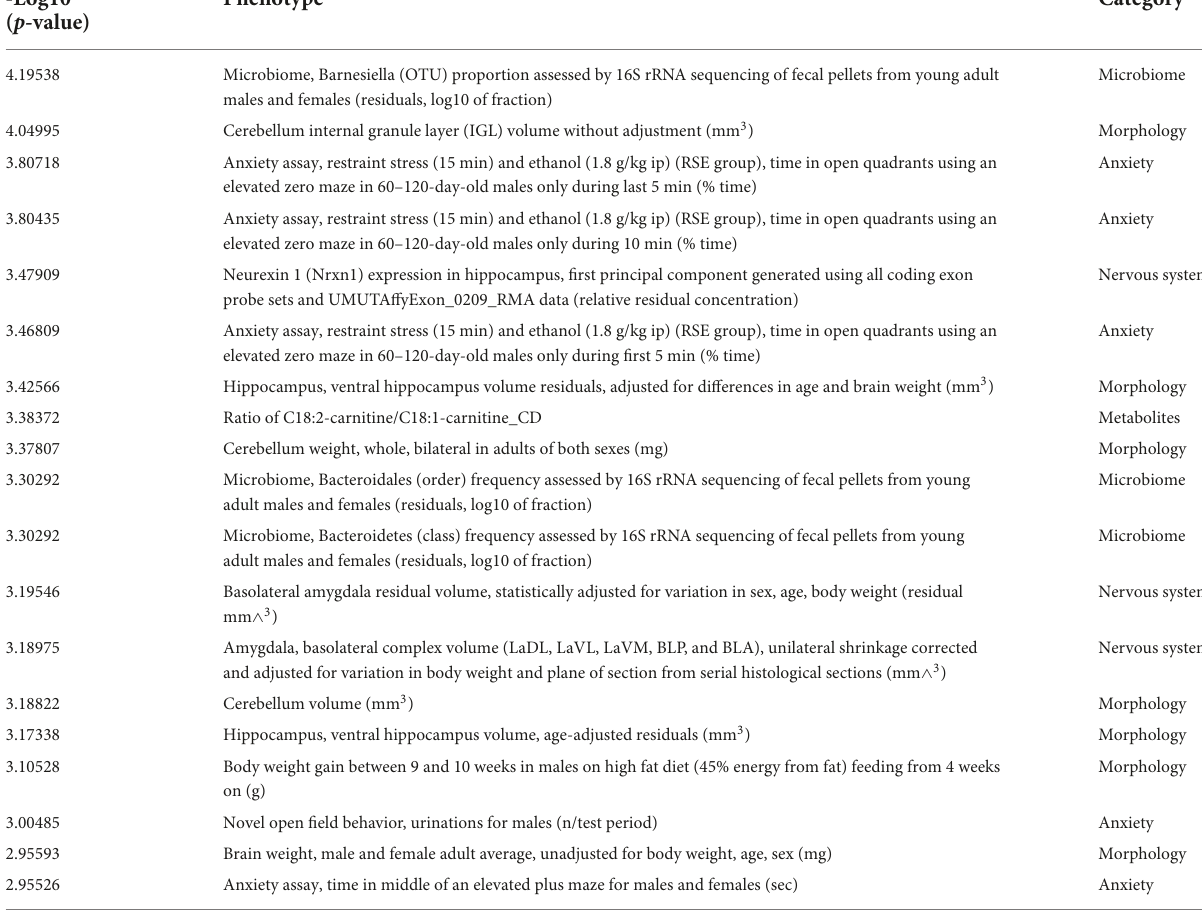
TABLE 1 Lists of the 19 Lpl-associated